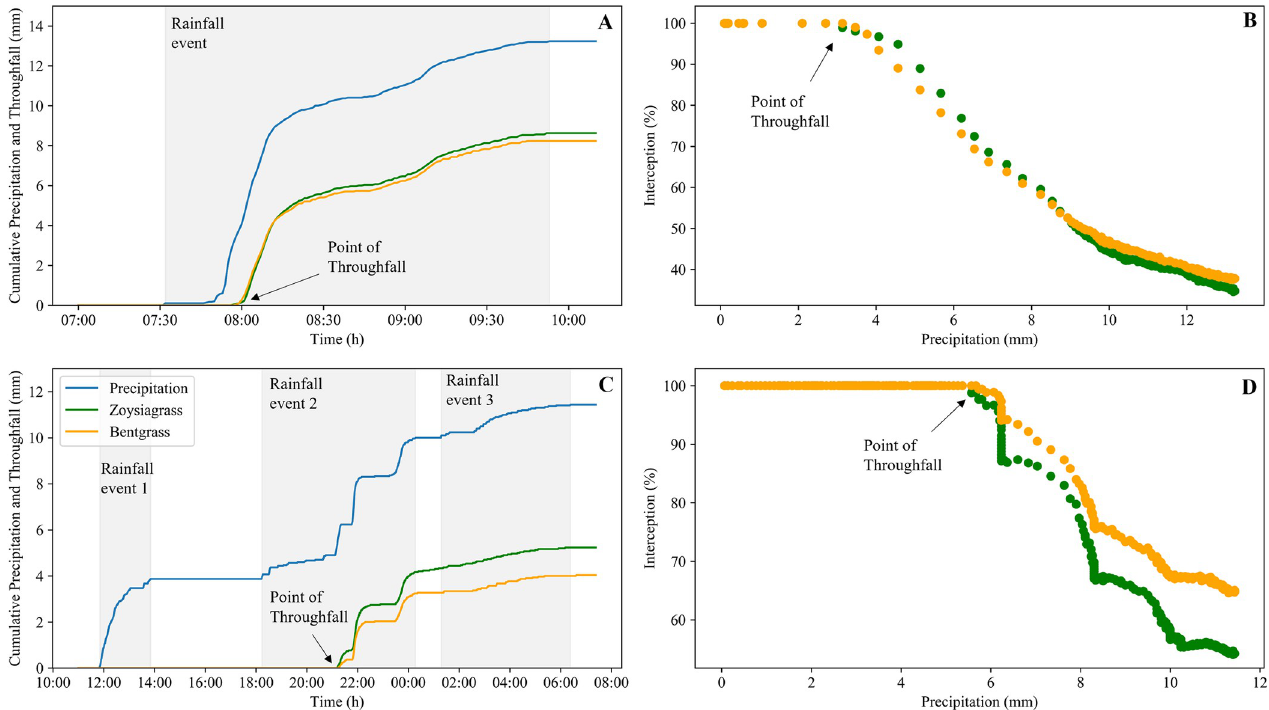
Fig 3. Comparison of cumulative precipitation, cumulative throughfall, and canopy interception for patches of zoysiagrass and creeping bentgrass during a storm with a single rainfall event (A and B, storm 14 in Table 1) and a storm with three rainfall events of variable lengths (C and D, storm 10 in Table 1). Both storms resulted in similar precipitation amount but had a different number of intra-storm precipitation events. The point of throughfall denoted by arrows.